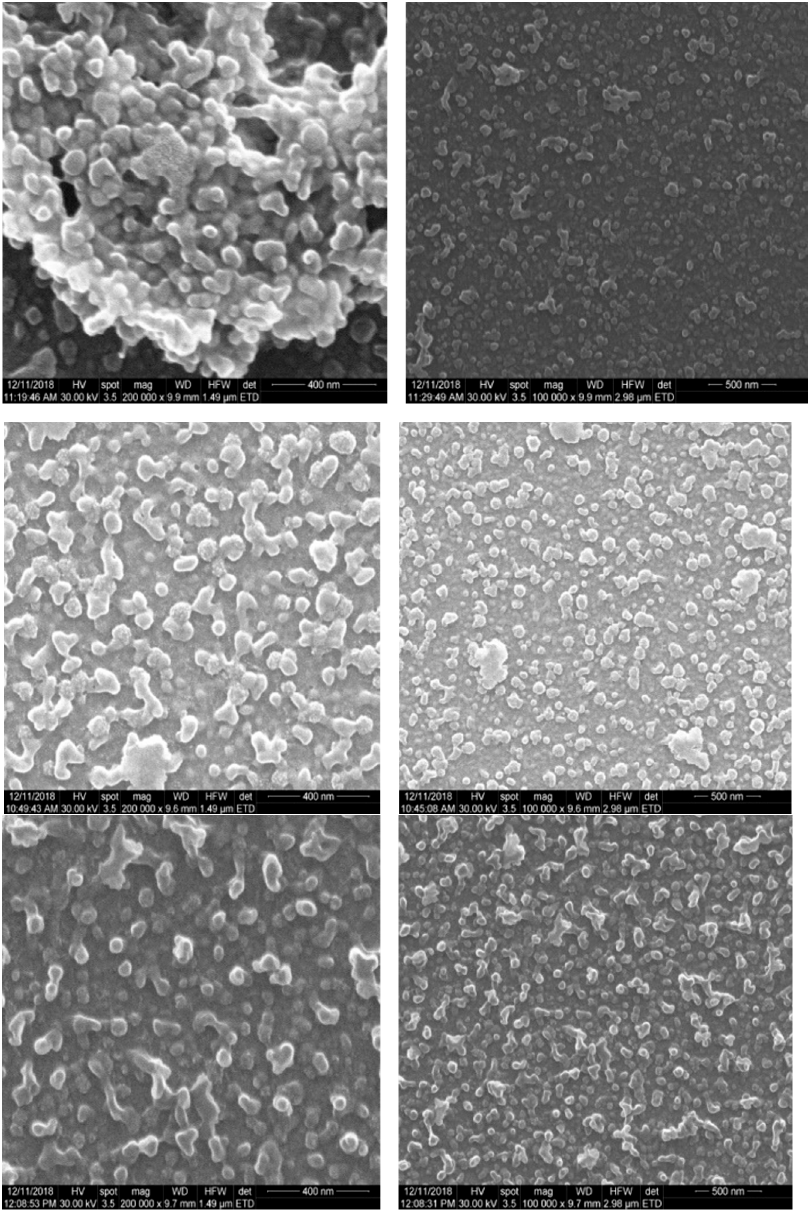
Figure 2. SEM images of PNIPAM/magnetite NPs at 30, 34, and 38 °C (0.25% PNIPAM solution).